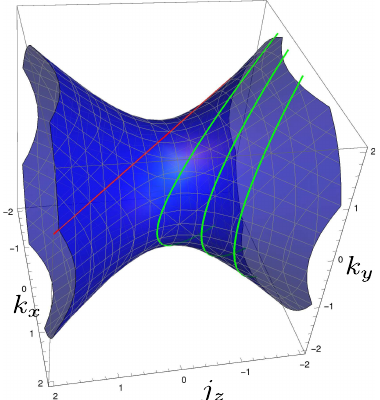
Figure 2: Plot of the physical trajectories corresponding to the flow generated by H on a fixed hyperboloid, for B = 1. For non-vanishing L the AdS hyperboloid. The green curves correspond to L = 0 in red gives a (null) geodesic, similarly to the trajectories of flat FLRW case L 0